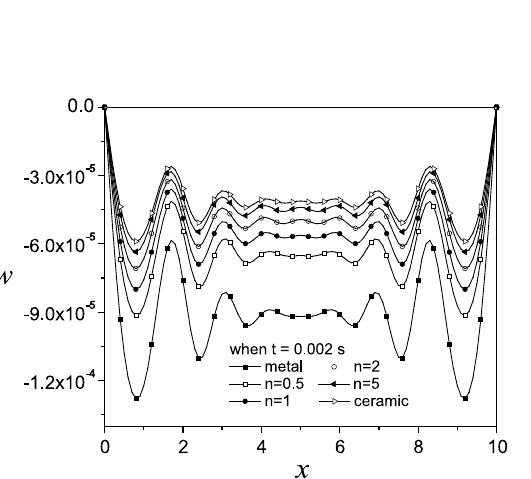
Fig. 16. Deflection of the mid-plane for the simply supported FGPM cylindrical shell imposed by a uniform mechanical load, when t = 0 . 002 .